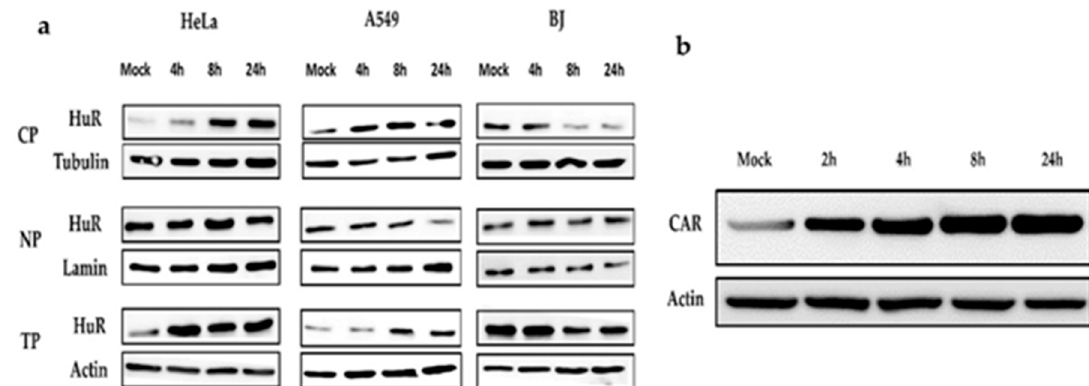
Figure 5. Effects of paclitaxel on cytoplasmic HuR exportation and expression of CAR. ( a ) Cancer cells (HeLa, A549) and normal cells (BJ) were treated with 4 nM paclitaxel (PTX). Cell lysates were separated into the cytoplasmic and nuclear fractions, and HuR localization was estimated by western blot analysis. The level of the HuR protein was monitored in total cell lysates (TP), cytoplasmic (CP), and nuclear extracts (NP). Tubulin, Lamin, and actin are used as the internal control for each fraction. ( b ) After treatment with PTX, total HeLa cell lysate was collected, and western blot analysis was performed to detect CAR.